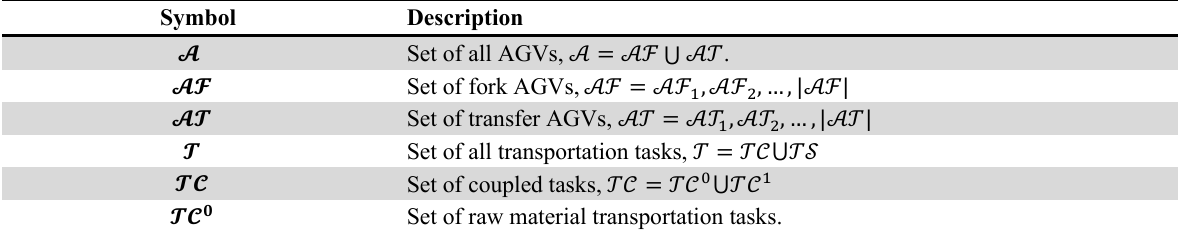
Notations Symbol